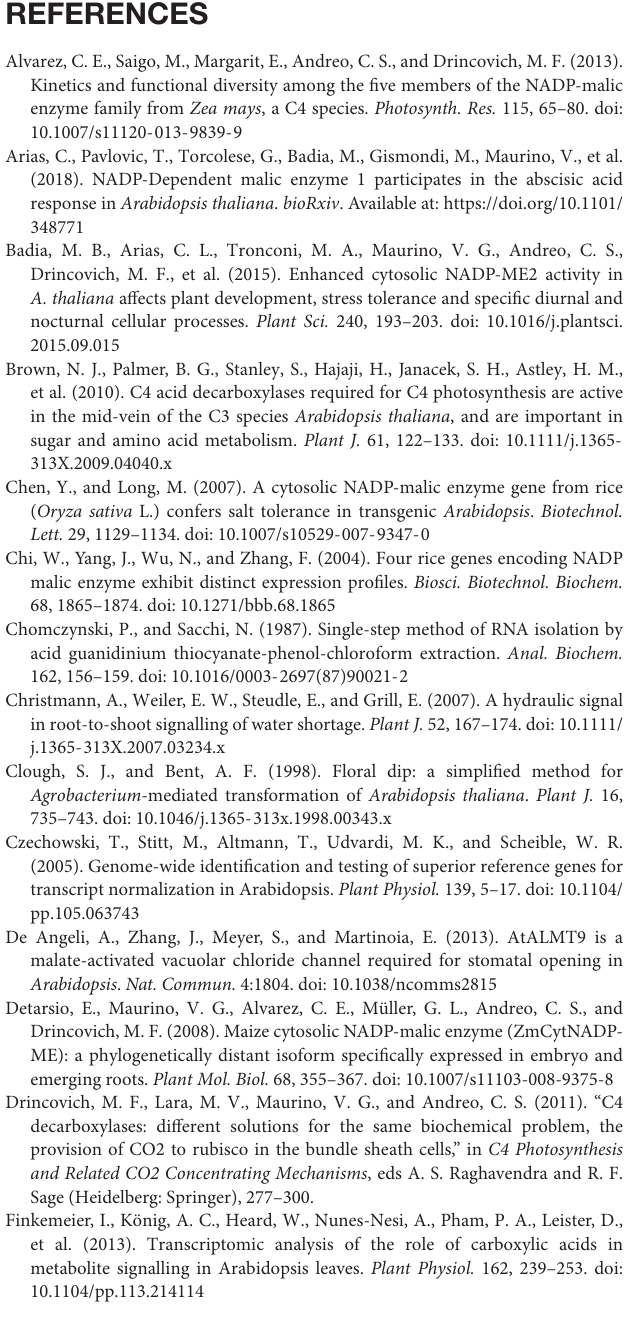
FIGURE S1 | NADP-ME1 expression in response to NaCl, mannitol and ABA. (A) Relative levels of the transcripts of NADP-ME genes in rosettes in control conditions (MS) or after 6 h treatments of seedling with 100 mM NaCl, 225 mM mannitol or 10 µ M ABA. The expression levels of NADP-ME genes are normalized